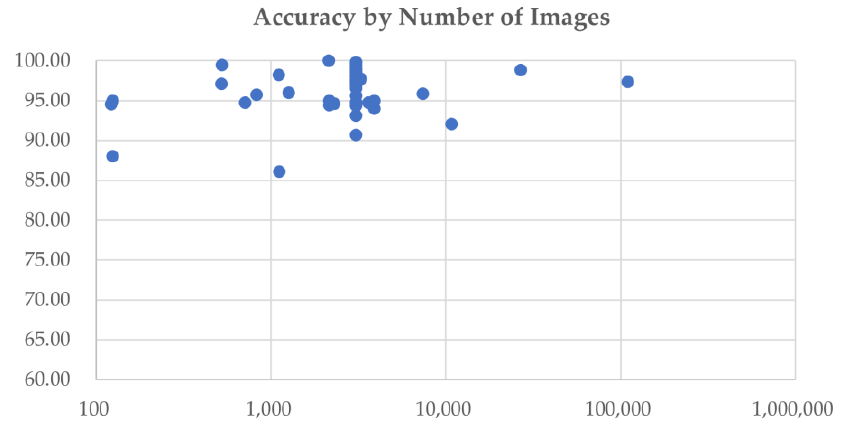
Figure 10. Classification accuracy by number of images.